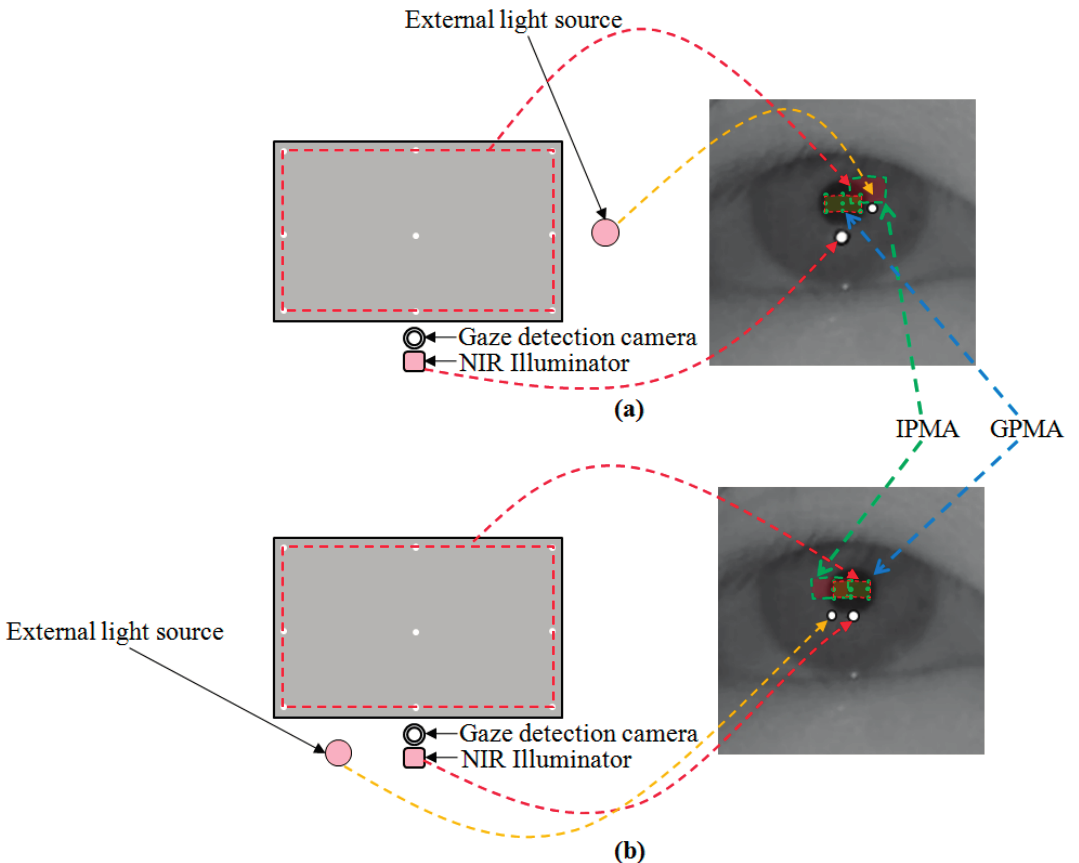
Figure 16. Third scenario (external light source exists in the right or left position of the NIR illuminator), and corresponding GPMA and IPMA: ( a ) External light source exists in the right position of the NIR illuminator; ( b ) External light source exists in the left position of the NIR illuminator.